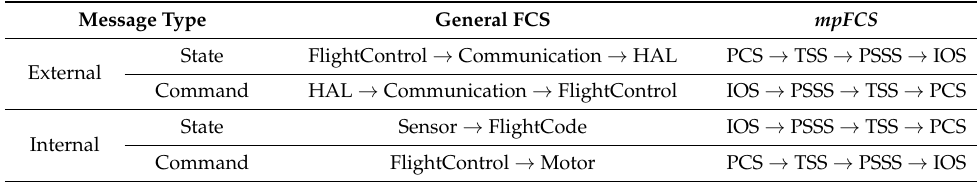
Table 5. A comparison of data flow between two